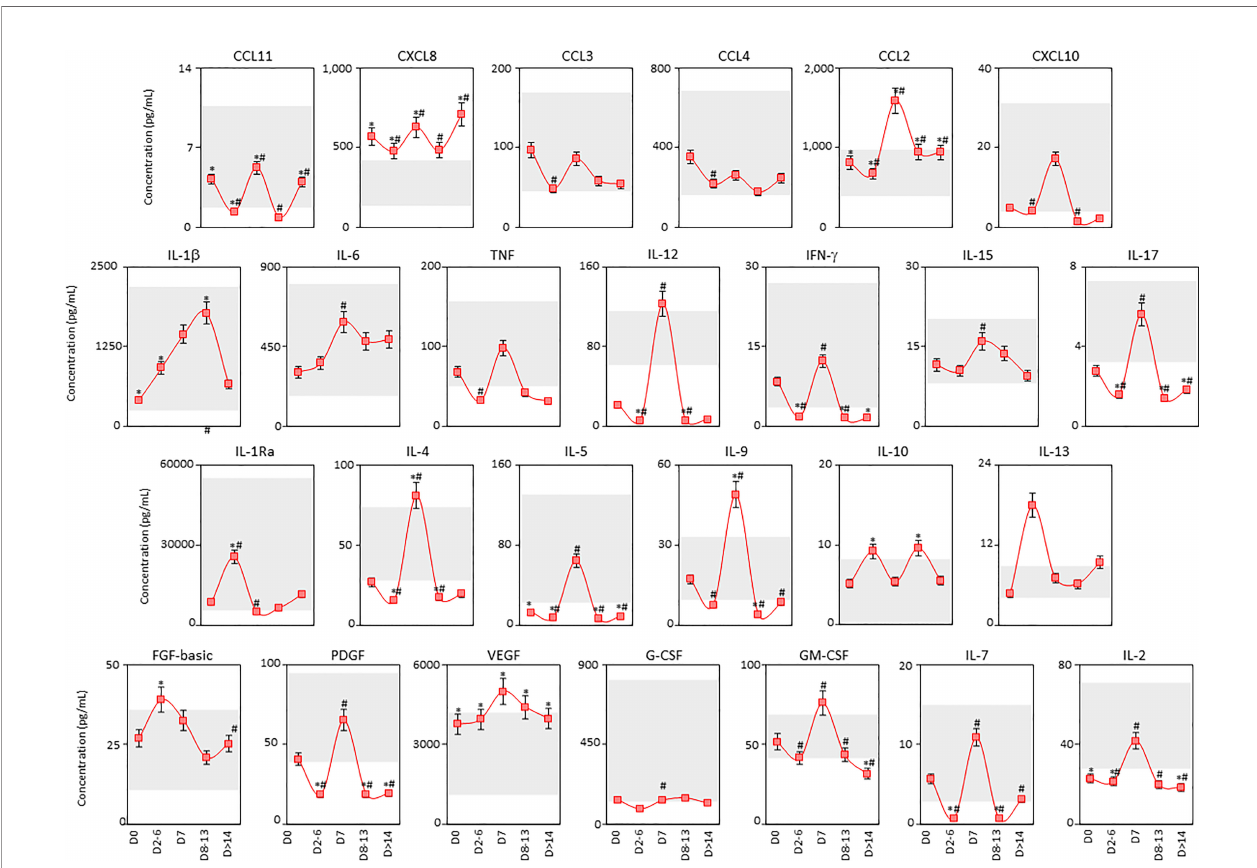
FIGURE 8 | Kinetics of airway soluble immune mediators in tracheal aspirate samples from critically ill COVID-19 patients. The kinetic timeline of chemokines (CXCL8, CCL11, CCL3, CCL4, CCL2, CXCL10), pro-in fl ammatory cytokines (IL-1 b , IL-6, TNF, IL-12, IFN- g , IL-15, IL-17), regulatory cytokines (IL-1Ra, IL-4, IL-5, IL- 9, IL-10, IL-13) and growth factors (FGF-basic, PDGF, VEGF, G-CSF, GM-CSF, IL-7 and IL-2) was evaluated in tracheal aspirate samples from critically ill COVID-19 patients ( ■ , n = 103) by cross-sectional analysis at fi ve consecutive time points (Days = D), including: D0 (n=103), D2-6 (n=37), D7 (n=19), D8-13 (n=20) and D > 14-36 (n=19) after ICU admission. Measurements were carried out by high-throughput microbeads array as described in Material and Methods section. The results are presented as a line chart of median values and interquatile range at each time point along the kinetic timeline. The gray zone represents the reference interquartile range (25 th -75 th ) observed for non-infected patients “ NI ” (n=18). Signi fi cant differences at p < 0.05 are identi fi ed by asterisks (*) as compared with “ NI ” and by hashtag (#) for immediately preceding